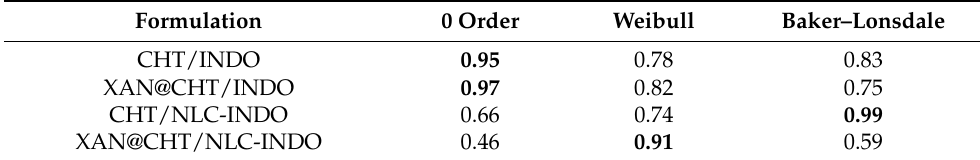
Table 5. Mathematical modeling of release kinetics, fitted with several mathematical models. The values displayed corresponds to the coefficient of determination (R 2 ), calculated by KinetD software. The highest R 2 for each group are in